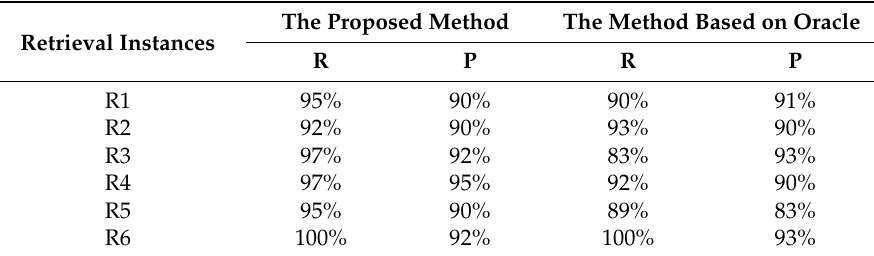
Table 6. Comparison of retrieval quality.